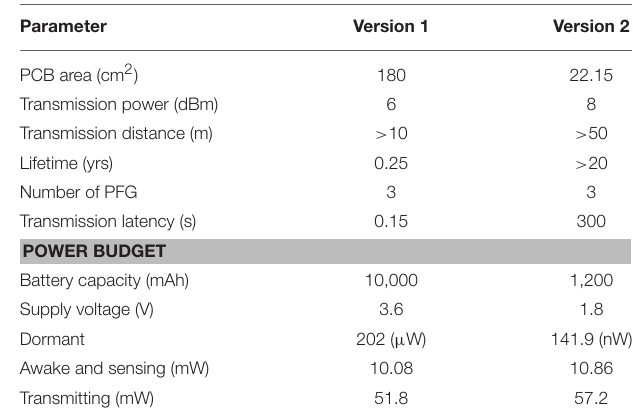
TABLE 3 | Prototype